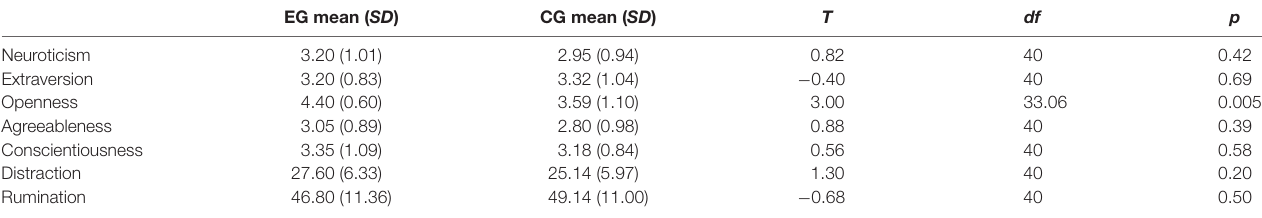
TABLE 2 | Results for personality and response style in both groups.